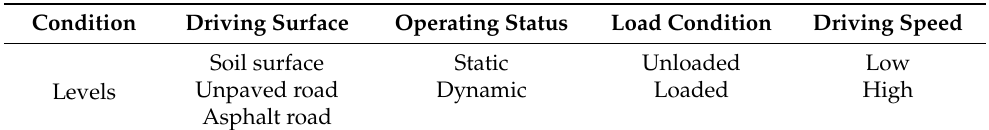
Table 3. Vibration exposure test conditions by driving surface, operating status, load condition, and driving speed.